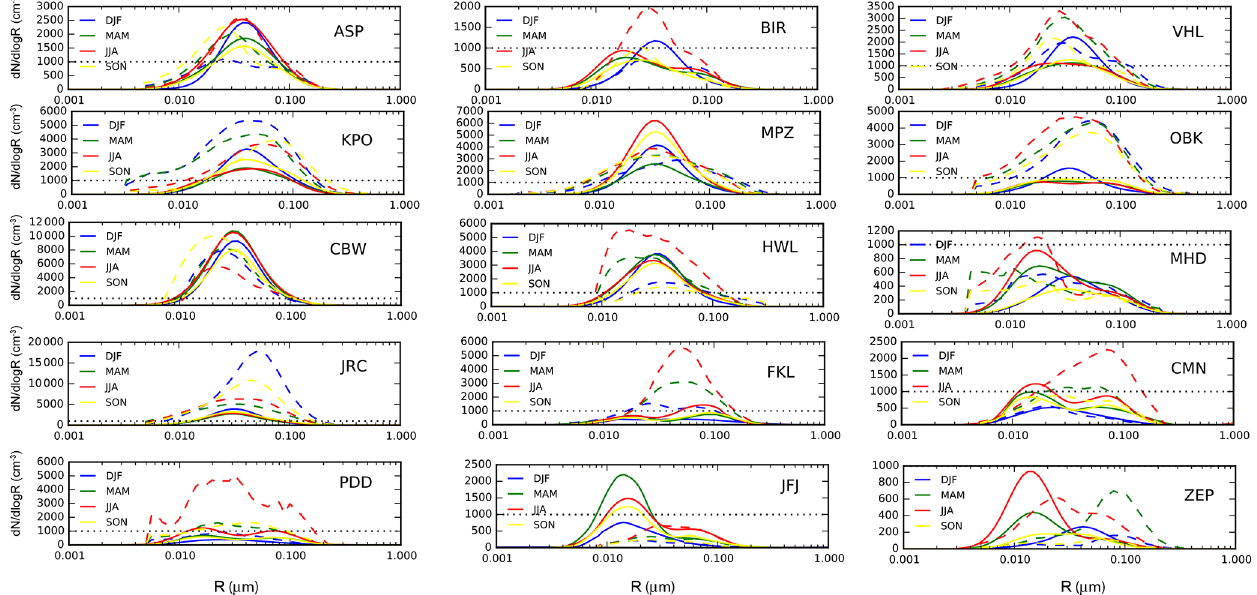
Figure 9. Observed (dashed lines) and simulated (solid lines) (NUDGE simulation) near-surface median aerosol size distributions for Eu- ropean field monitoring sites (EUSAAR) for 2009 (Asmi et al., 2011a). Data are for winter (blue), spring (green), summer (red), and fall (yellow). The simulated size distributions are the median of the number of daily mean size distributions per season. The top panels contain data for three Nordic and Baltic stations (ASP: Aspvreten; BIR: Birkenes; VHL: Vavihill), the second row contains central European sites (KPO: K.Puszta; MPZ: Melpitz; OBK: Košetice), and the third row western European stations (CBW: Cabauw; HWL: Harwell; MHD: Mace Head). The fourth row represents stations in Mediterranean countries (JRC: Ispra; FKL: Finokalia; CMN: Monte Cimone), and the fifth row represents high-altitude (PDD: Puy de Dôme; JFJ: Jungfraujoch) and Arctic (ZEP: Zeppelin)